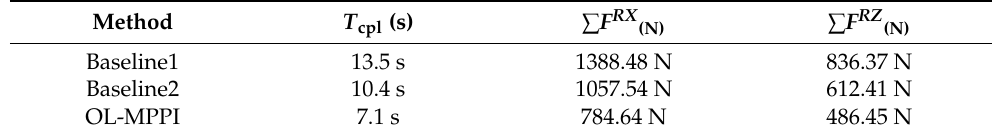
Table 1. Duration and wear of the peeling